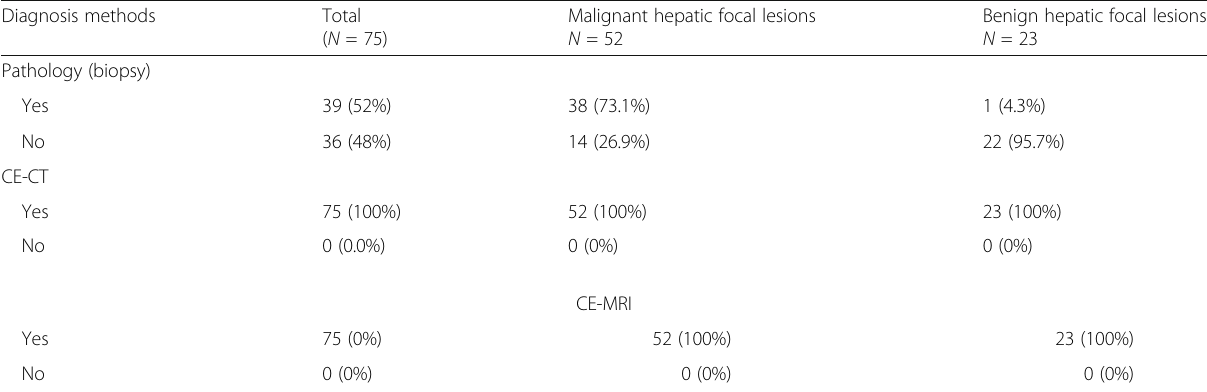
Table 1 Diagnosis methods among the studied groups Diagnosis